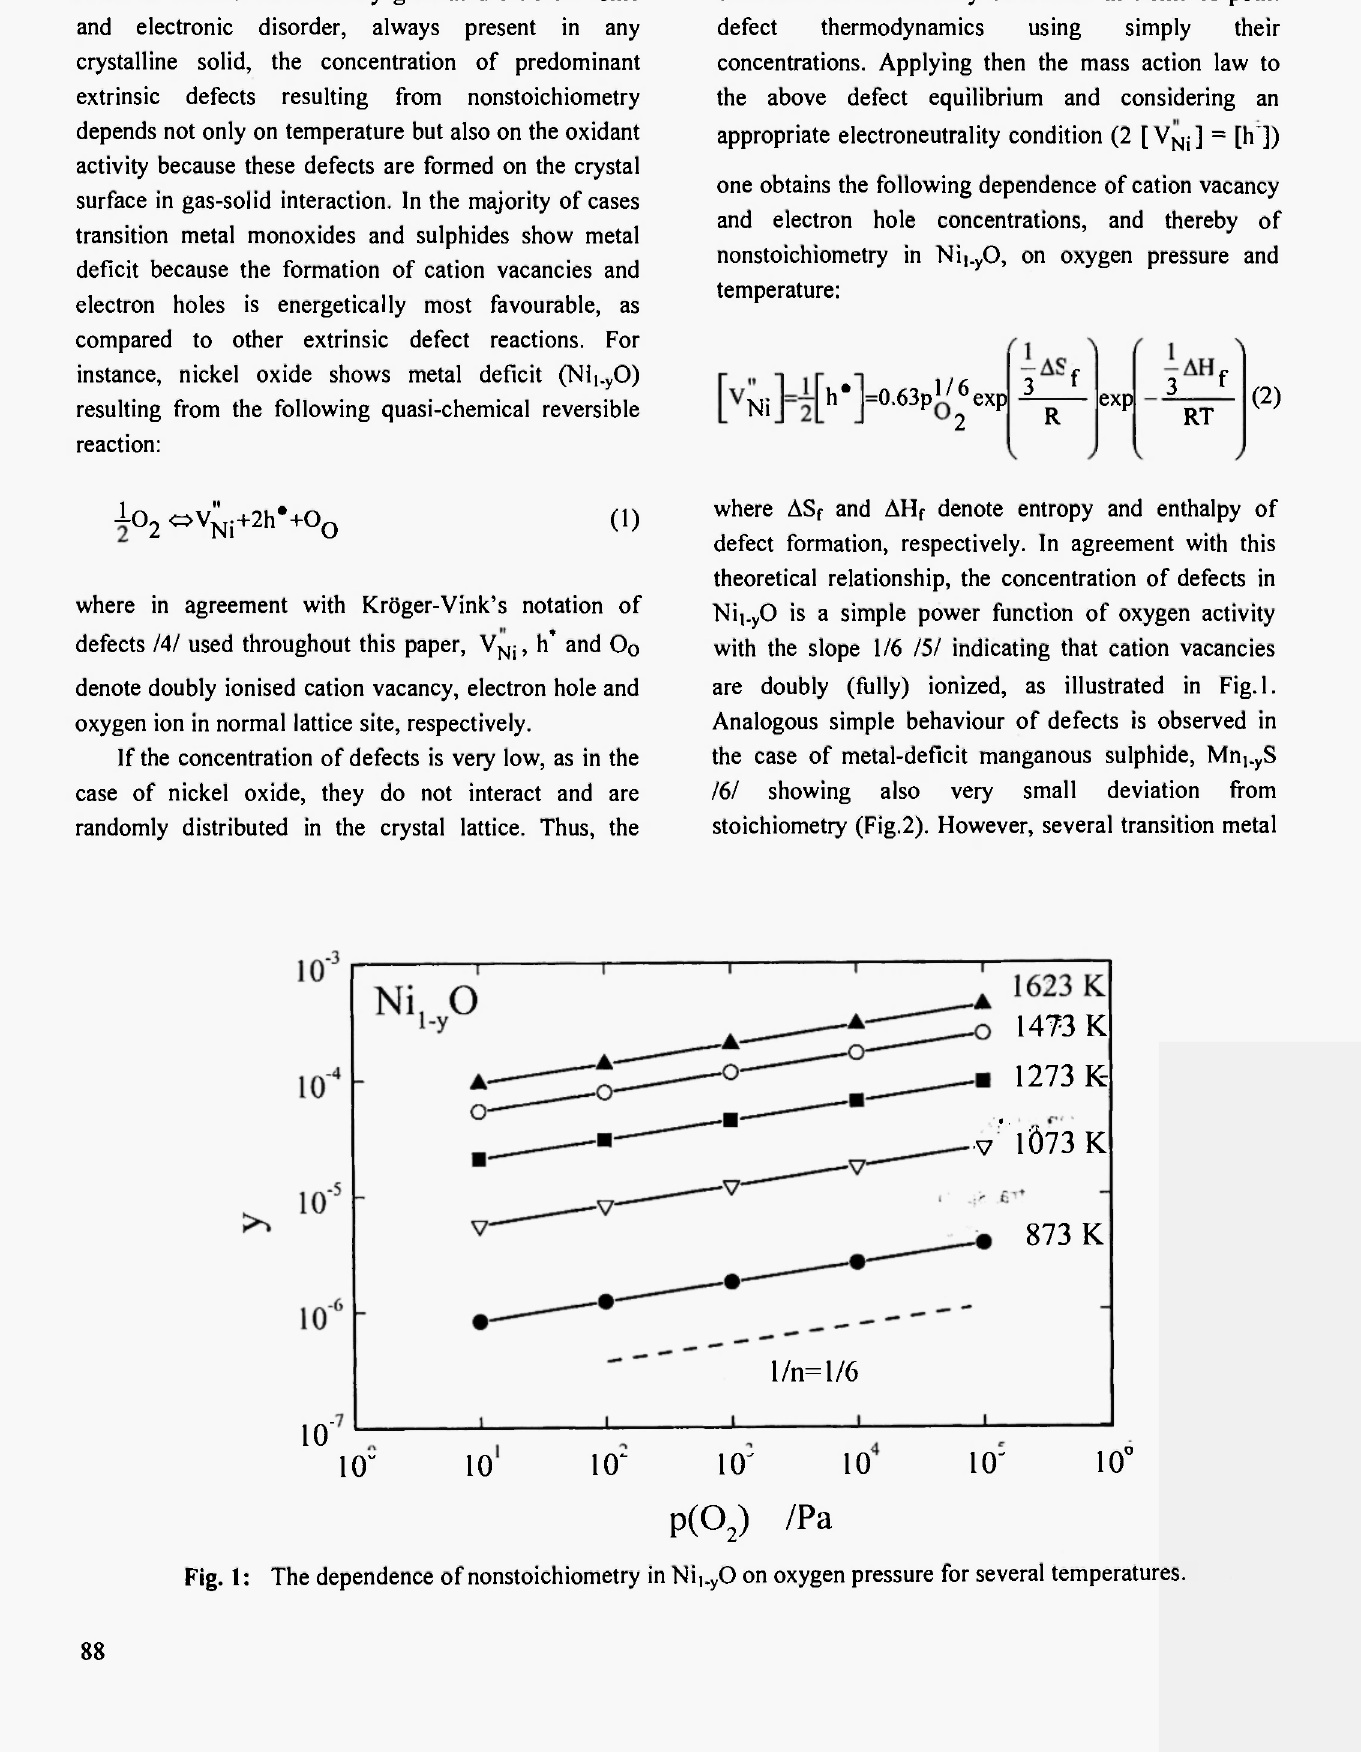
Fig. 1: The dependence of nonstoichiometry in Ni^O on oxygen pressure for several